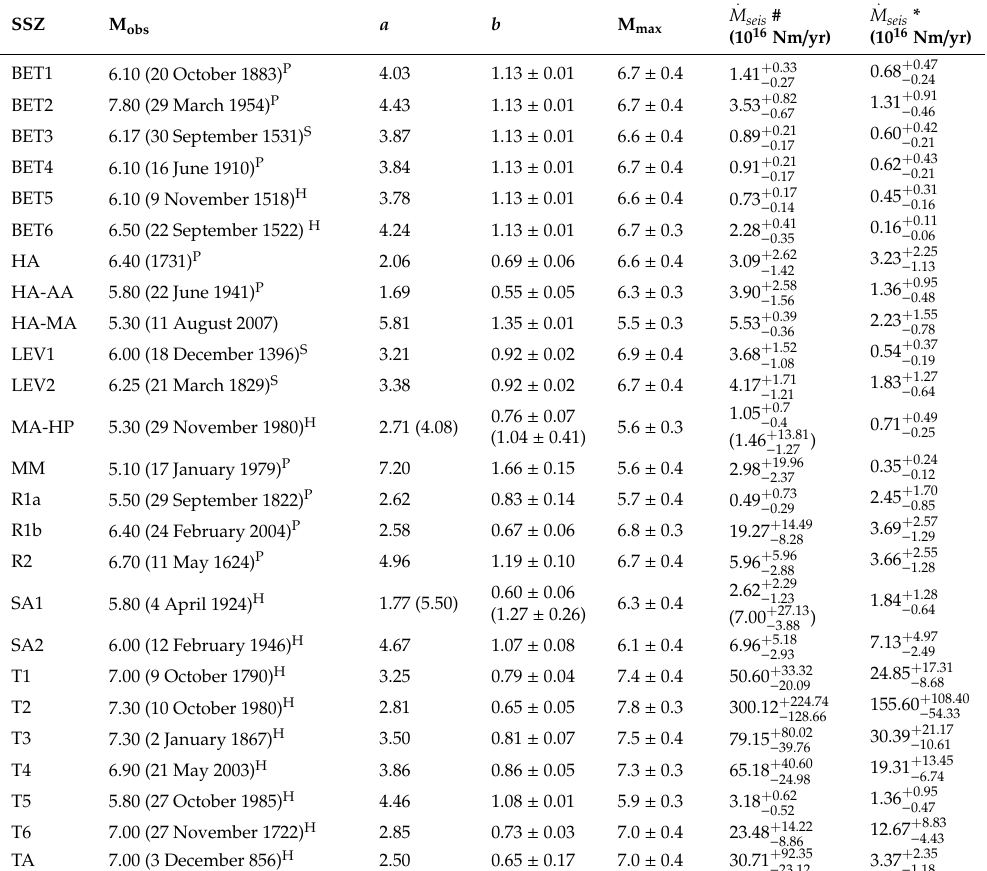
Table 1. Earthquake catalog statistic and estimated seismic moment-rates ( for each seismic source zone (SSZ). Moment-rates have been estimated by using both a (#) truncated cumulative Gutenberg–Richter distribution [16] and the (*) the moment summation [6] approach. Seismicity rate (a) and slope (b) of the Gutenberg–Richter recurrence relation with its associated error are reported, as well as the values of the maximum magnitude observed (M obs ) and estimated (M max ). Abbreviations are as follows: P, [37]; H, [38], S, [36]. Because of the large uncertainties of MA-HP and SA1, we also reported the recomputed a and b values (see the main text for details); in curved brackets the original